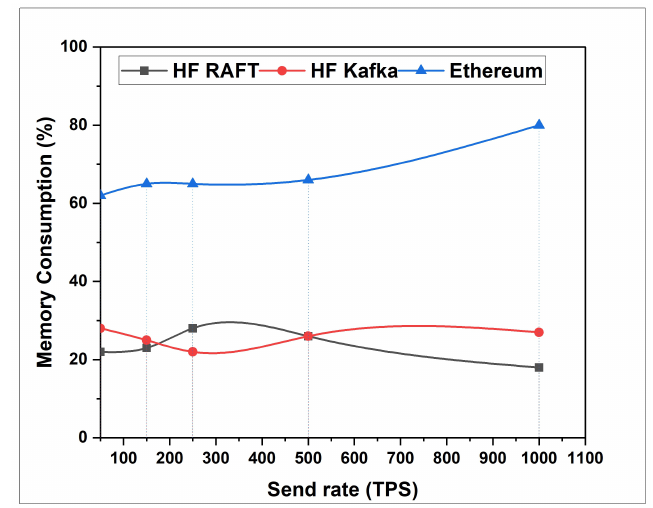
Figure 4. Memory Consumption for